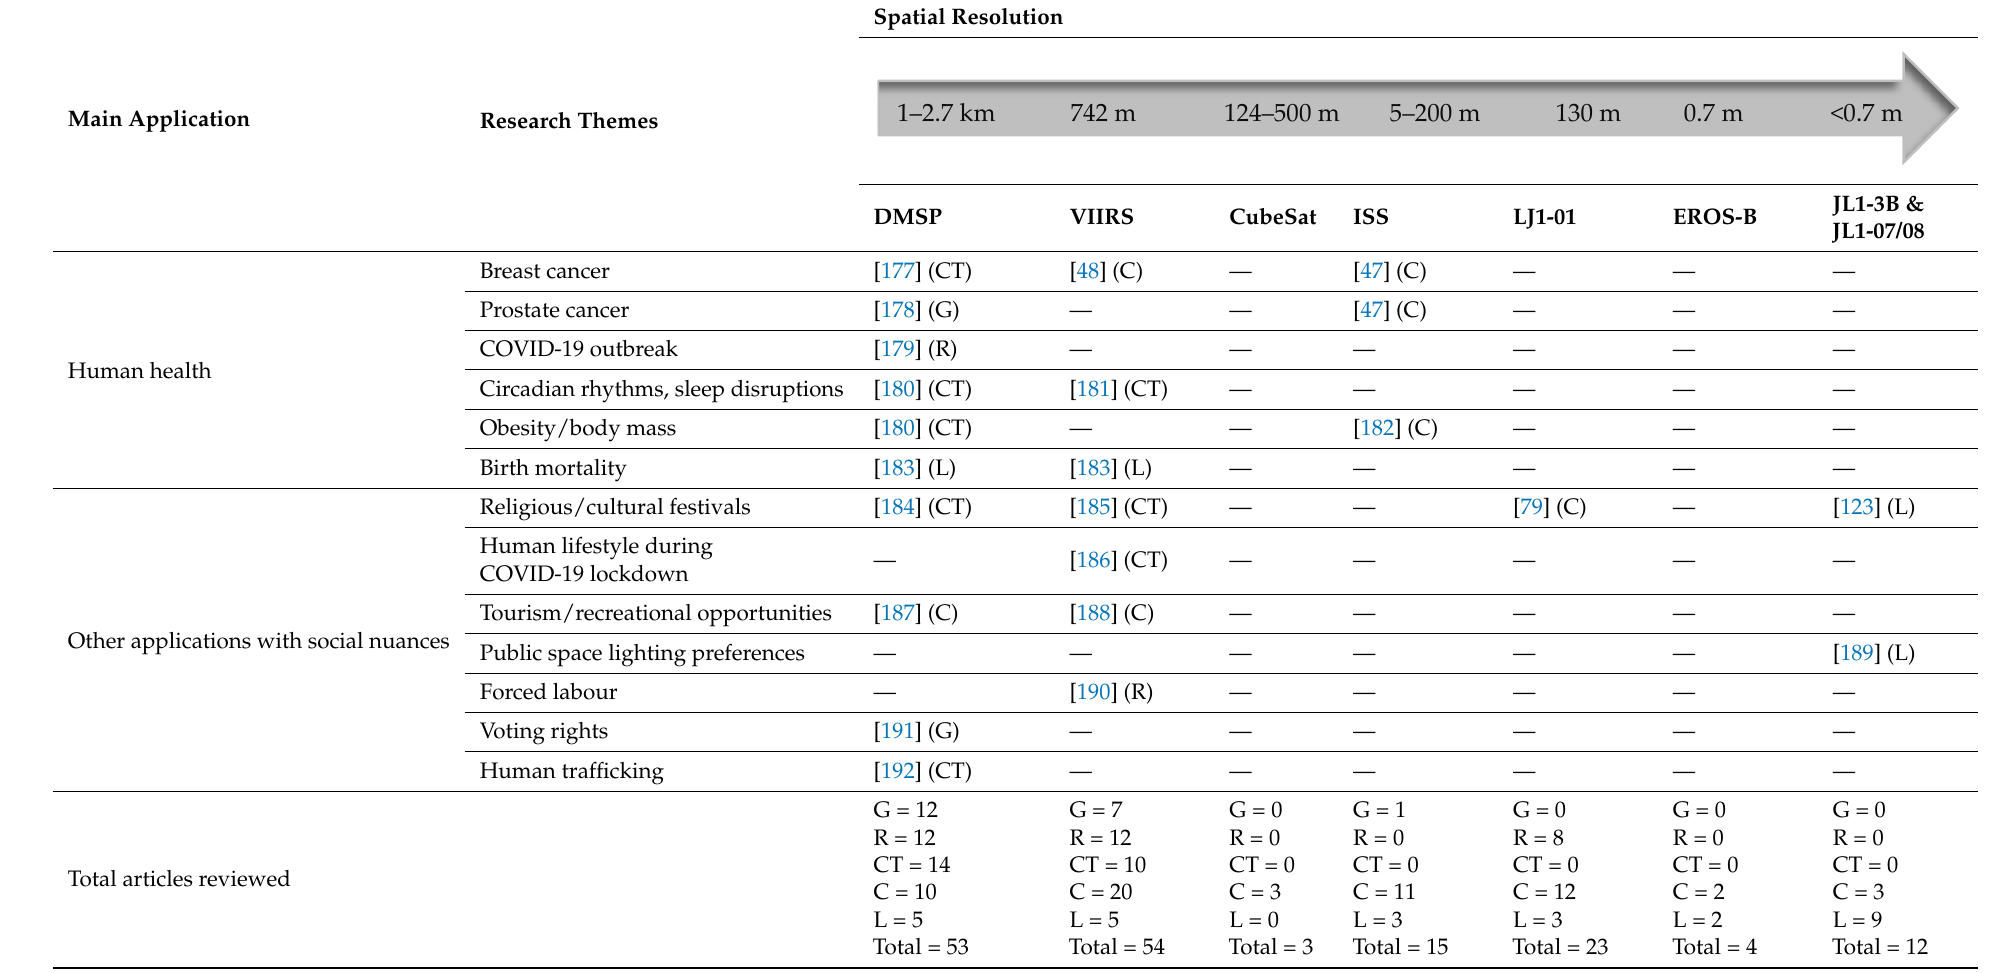
Table 3. Applications of night-time satellites by spatial resolution and location. G — Global; R — Regional, CT — Country; C — City; L — Table 3. Cont.